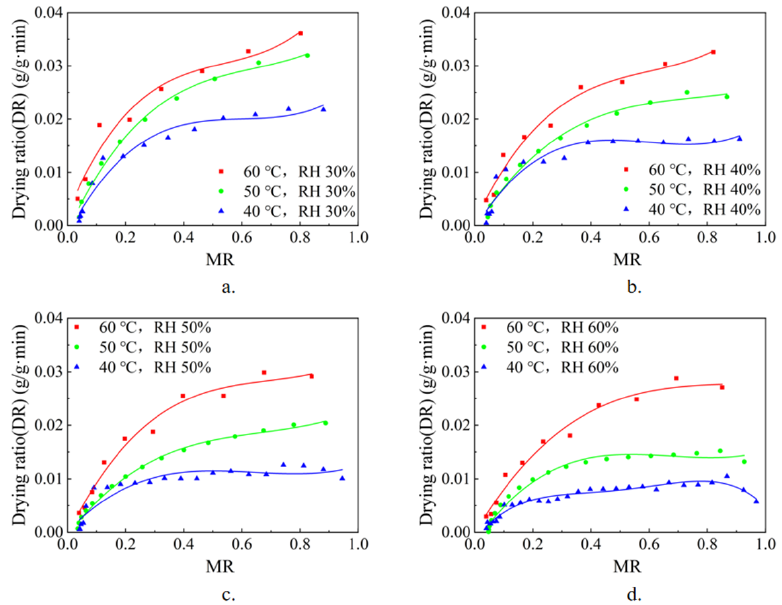
Figure 5. Sludge drying ratio versus the MR under different temperatures at a relative humidity of ( a ) 30%, ( b ) 40%, ( c ) 50%, and ( d ) 60%. ( a ) 30%, ( b ) 40%, ( c ) 50%, and ( d )